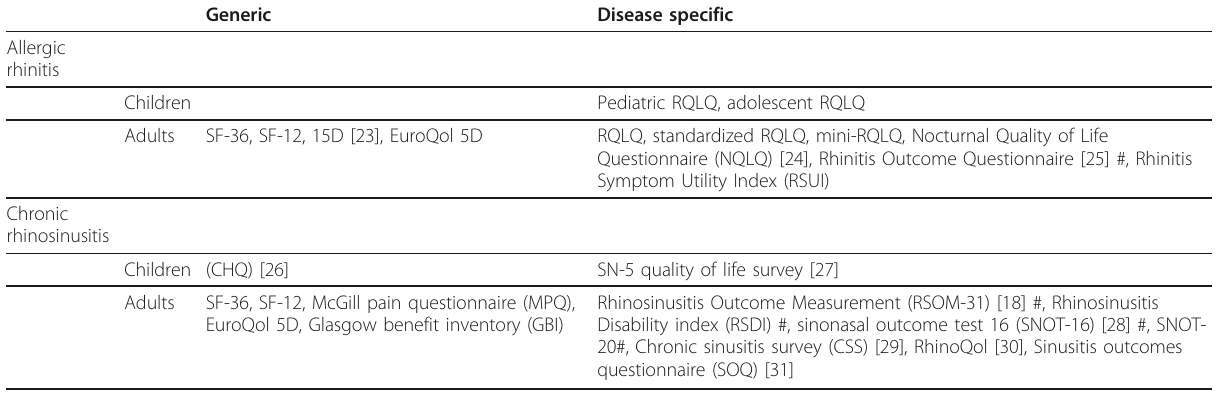
Table 1 Instruments used in allergic rhinitis and in chronic rhinosinusitis